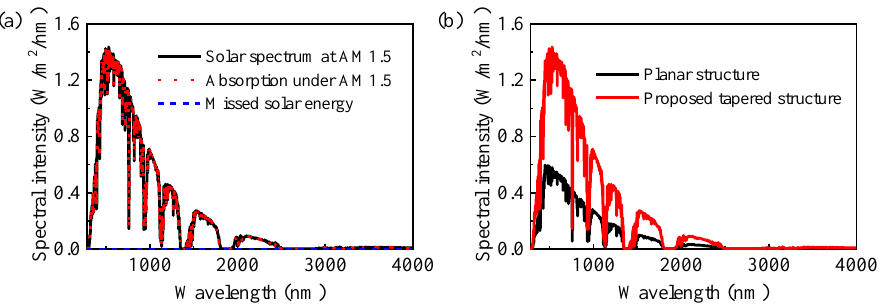
Figure 2. ( a ) Absorption spectra of the designed absorber in the solar spectrum at AM 1.5 illumination; ( b ) comparison of the absorption spectra of the designed structure and its planar counterpart in the solar spectrum at AM 1.5